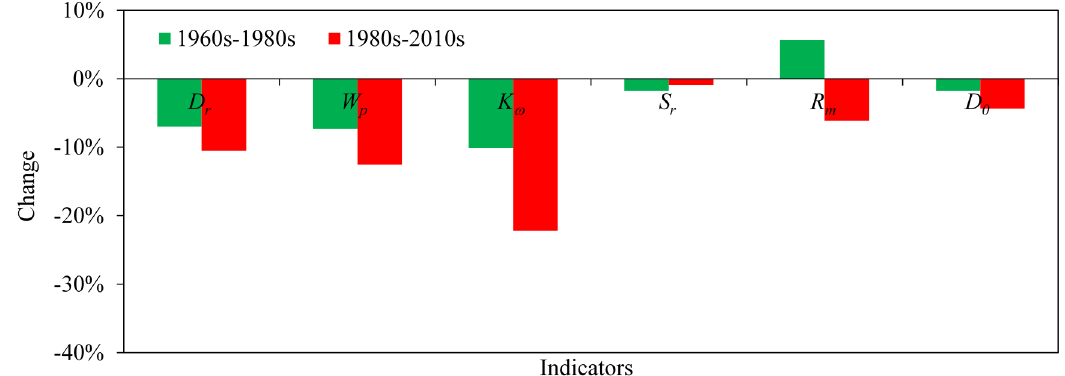
Figure 2. The direction and magnitude of river system changes in the Taihu Region in different